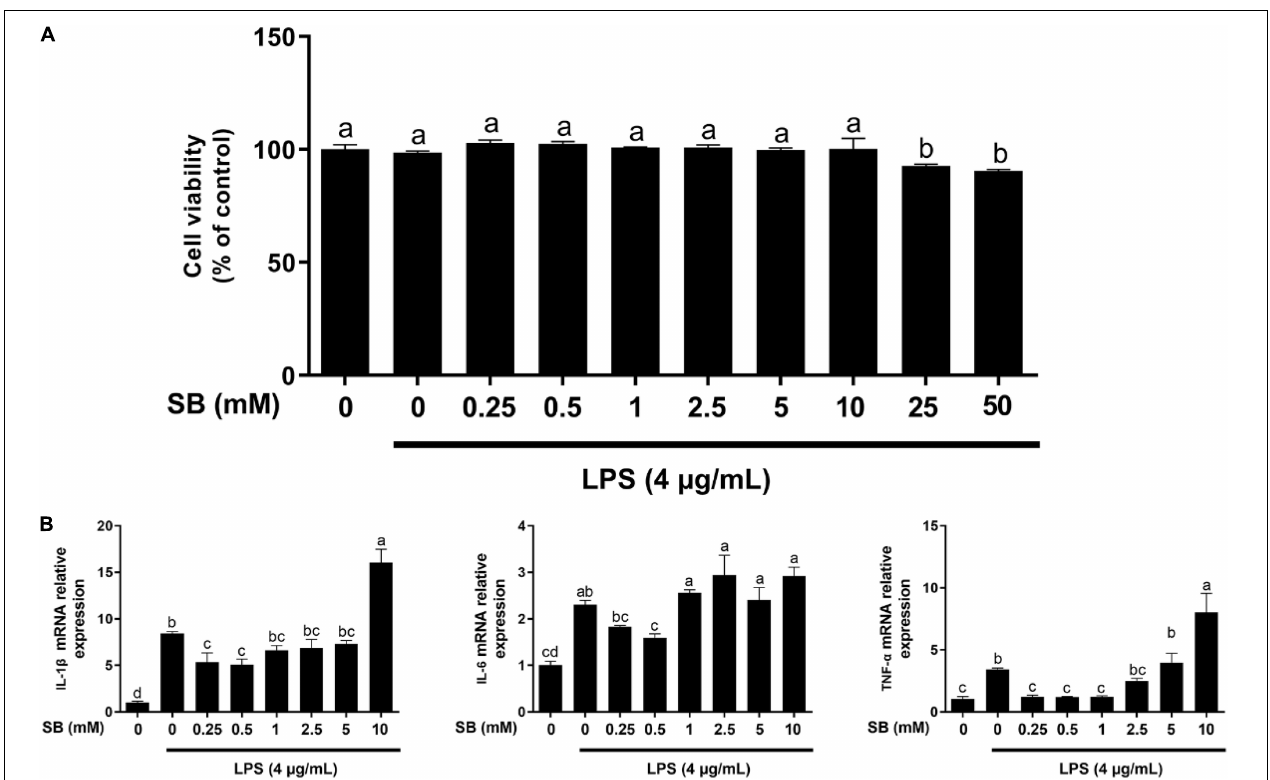
FIGURE 1 | Effects of sodium butyrate (SB) on cell viability and gene expression of inflammatory cytokines. (A) Bovine rumen epithelial cells (BRECs) were treated with DMEM/F12 (Control group); or with different concentrations of SB (0, 0.25, 0.5, 1, 2.5, 5, 10, 25, and 50 mM) for 18 h, followed by a challenge with 4 µ g/mL lipopolysaccharide (LPS) for an additional 6 h. Cell viability was determined using the Cell Counting Kit-8 Assay (Dojindo, Kumamoto, Japan). Values are shown as mean ± SEM ( n = 6). (B) Bovine rumen epithelial cells were pretreated with different concentrations of sodium butyrate (0.25, 0.5, 1, 2.5, 5, and 10 mM) for 18 h and then treated with 4 µ g/mL LPS for 6 h. The gene expression of IL-1 β , IL-6, and TNF- α was analyzed by qRT-PCR, which are normalized to GAPDH. Values are shown as mean ± SEM ( n = 3). Different lowercase letters in the bar chart indicate significant differences ( P <